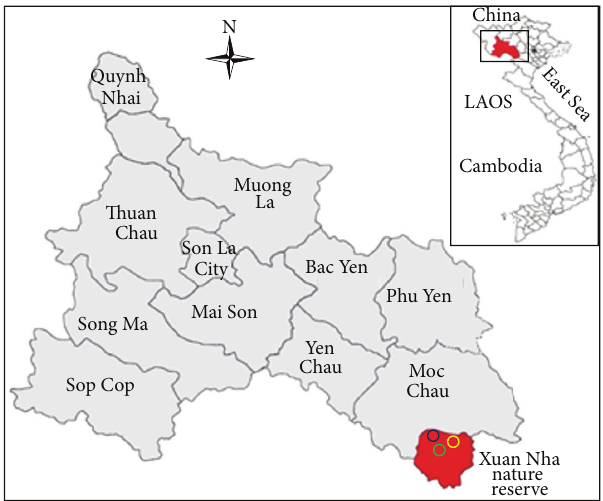
Figure 1: The location of Xuan Nha Nature Reserve in Vietnam. Dark blue, yellow, and green colors indicate the undisturbed forest (UDF), lightly disturbed forest (LDF), and highly disturbed forest (HDF),